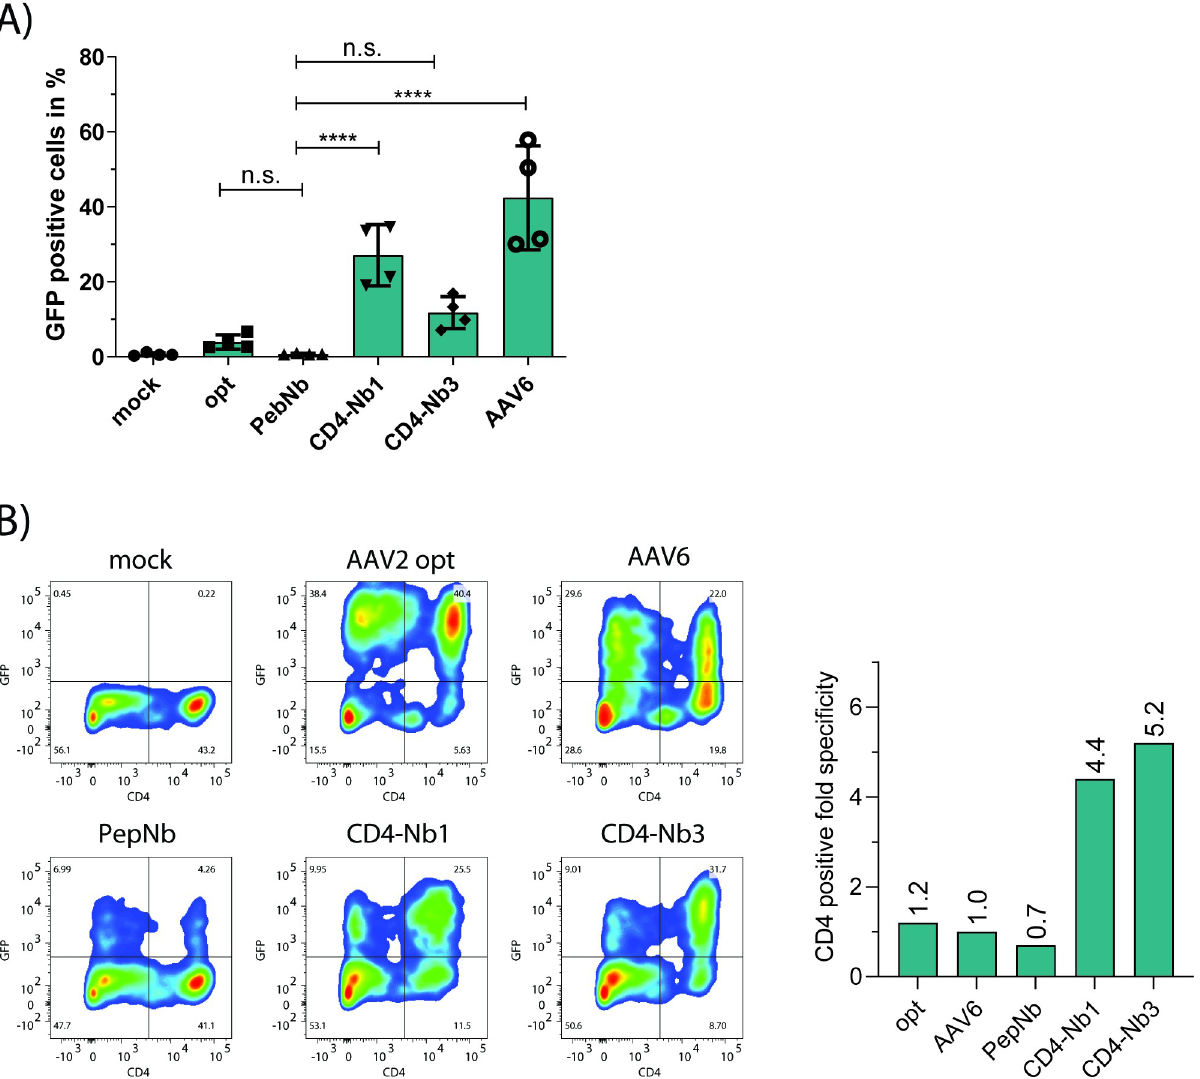
Fig 5. AAV2 VP1 CD4 Nb specificity in primary CD4 + T and PBMC. (A) Primary human CD4 + T cells from two healthy donors were CD3/CD28 activated and transduced with the indicated vector stocks (20,000 gc/cell). Three days post transduction, cells were stained for CD4 and analyzed for GFP expression by flow cytometry. Error bars indicate the SD; n = 4; n.s. not significant; ���� p < .0001. (B) Primary human PBMC were CD3/CD28 stimulated and subsequently infected with the indicated vector stocks (10,000 gc/cell). Three days post transduction, cells were stained for CD4, and GFP expression was assessed via flow cytometry (left panels). Fold specificity for CD4 positive cells (right panel) was plotted from relative eGFP positive populations in CD4 negative and positive cells. Data from one representative experiment.